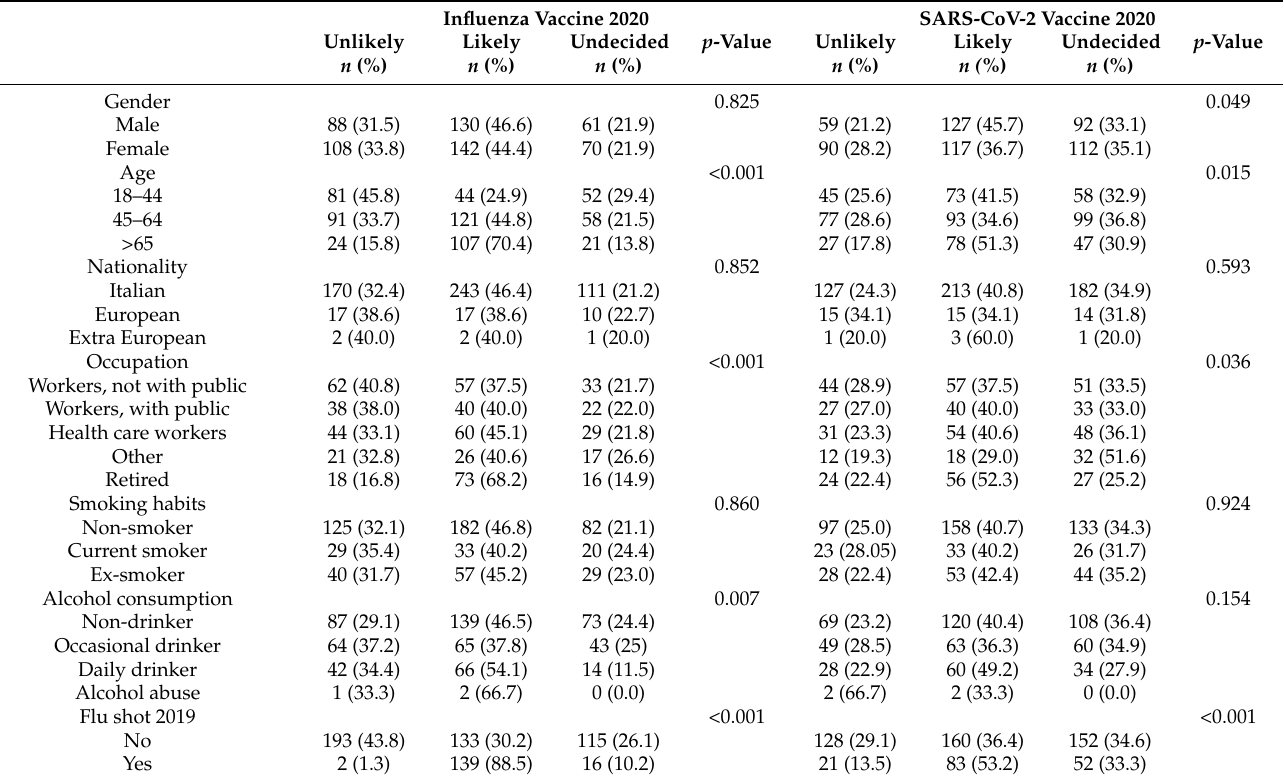
Table 1. Demographic characteristics of participants according to their attitudes towards vaccination.